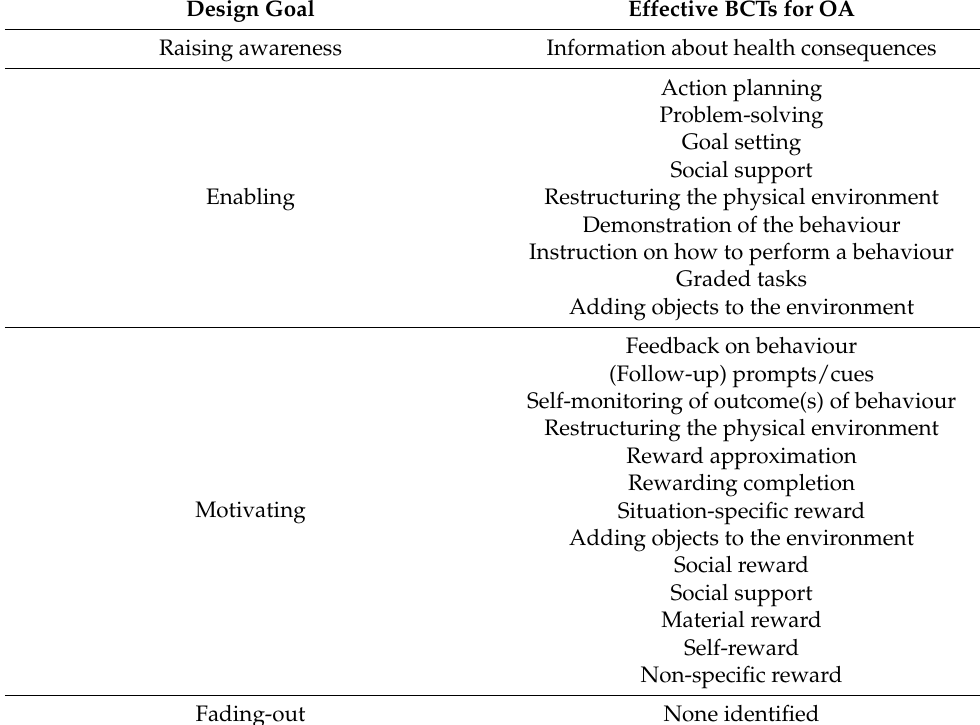
Table 2. Effective BCTs for OA (categorised by design